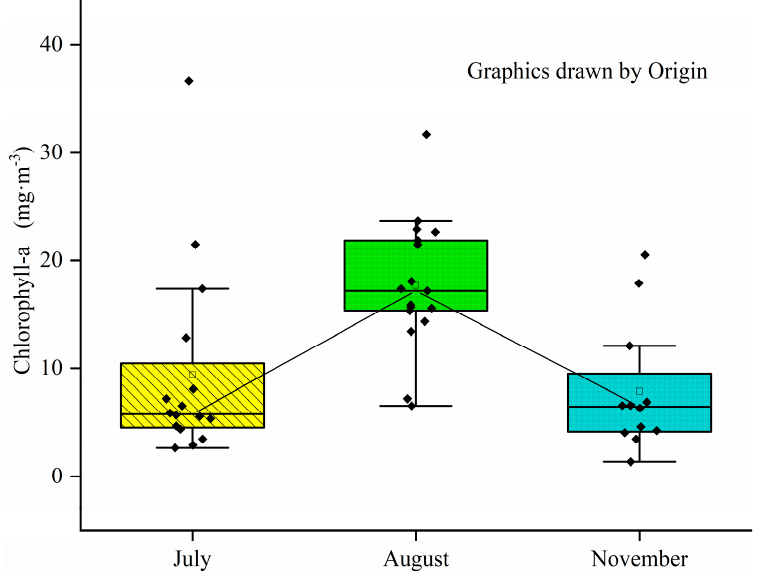
Figure 5. Spatiotemporal values of chlorophyll- a concentration at 17 locations within the Maotiao River Basin (Gizhou province, SW China) in 2020.